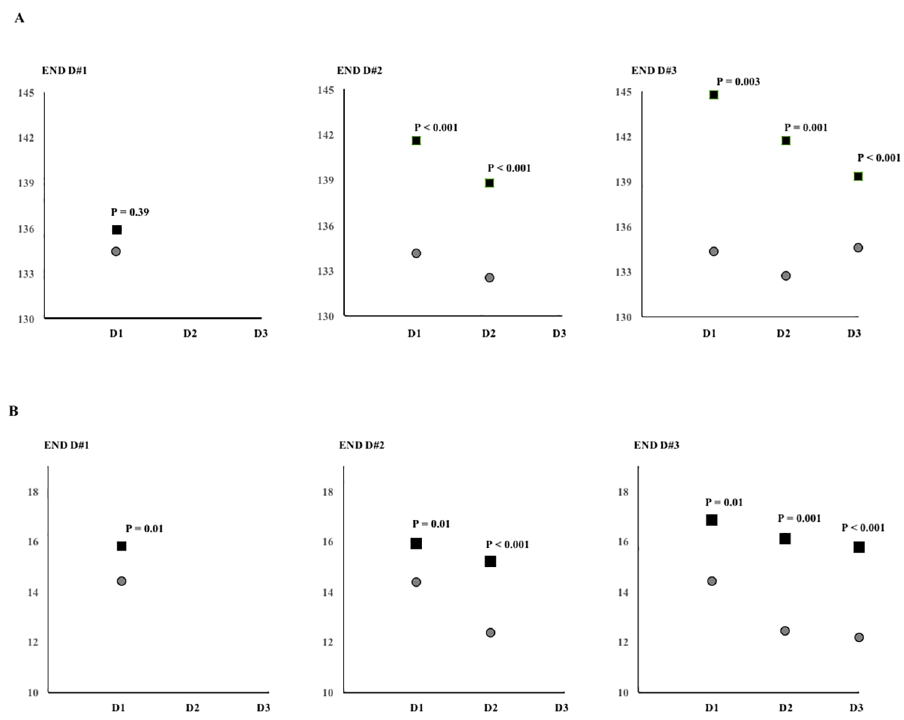
Fig 2. Comparisons of daily SBP parameters according to daily END. The daily means (A) and standard deviations (B) of SBP are shownas patients with END (box) and without END (circle).